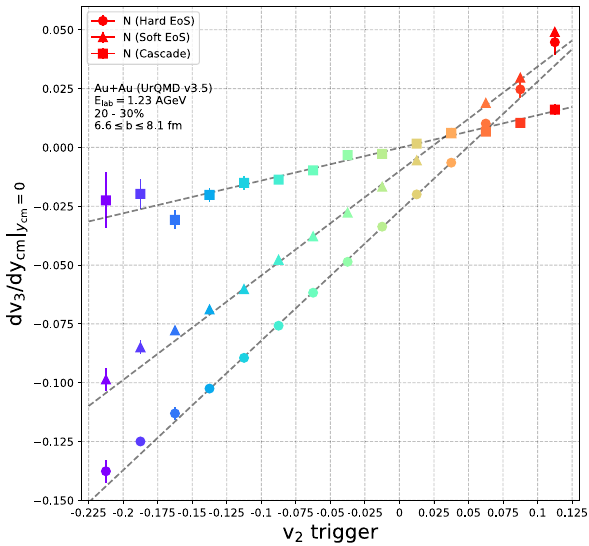
Fig. 6 The quadrangular flow component v 4 of nucleons at y cm = 0 as a function of the final state elliptic flow v 2 (colored full symbols) integrated over − 0 . 5 ≤ y cm ≤ 0 . 5 for a hard EoS (circles), a soft EoS (triangles) and in cascade mode (squares) from 20–30% peripheral Au+Au collisions at 1.23 AGeV from UrQMD